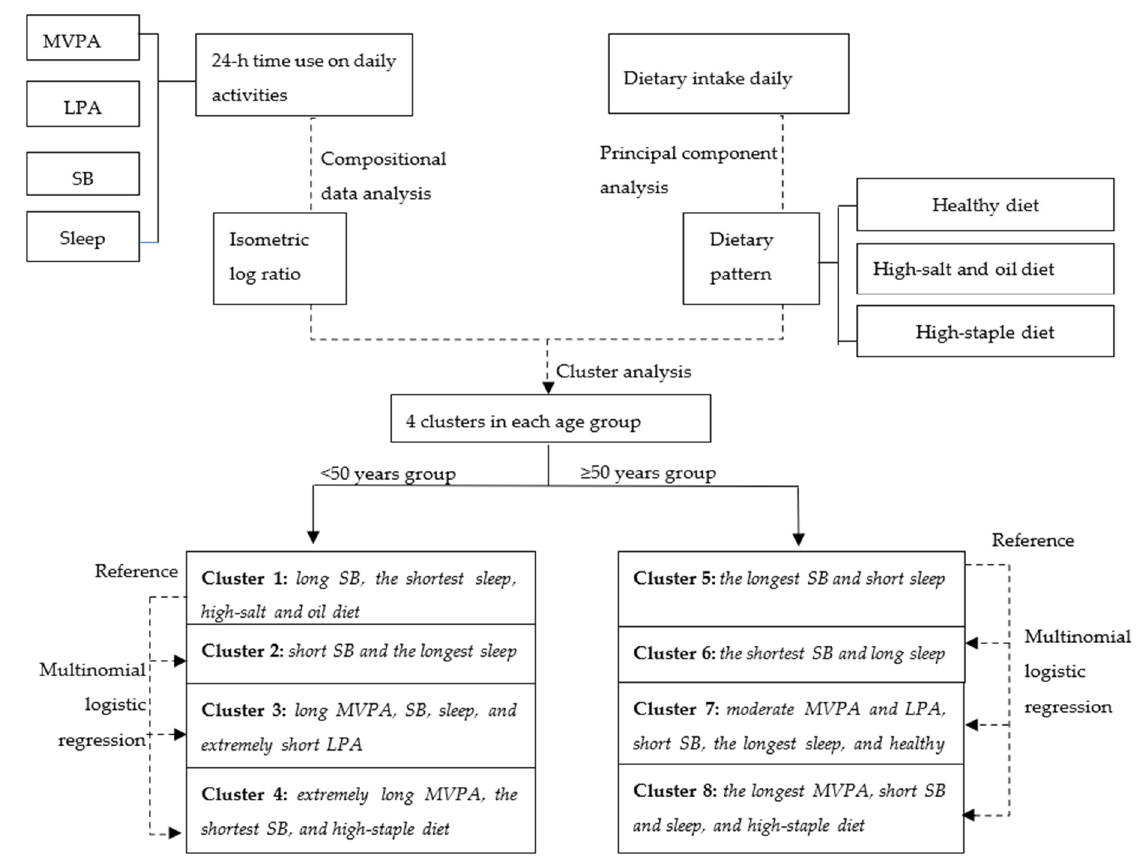
Figure 1. Flow chart of statistical analyses. SB, sedentary behavior; MVPA, moderate-to-vigorous intensity physical activity; LPA, light intensity of physical activity.